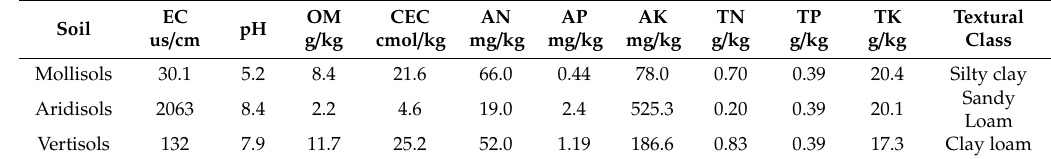
Table 4. Properties of the soils used in the